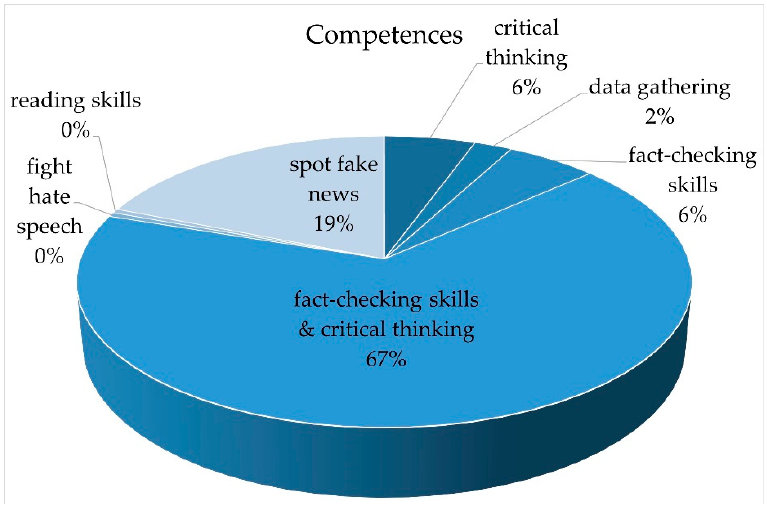
Figure 5. Competences that favor library practices. Source: prepared by the